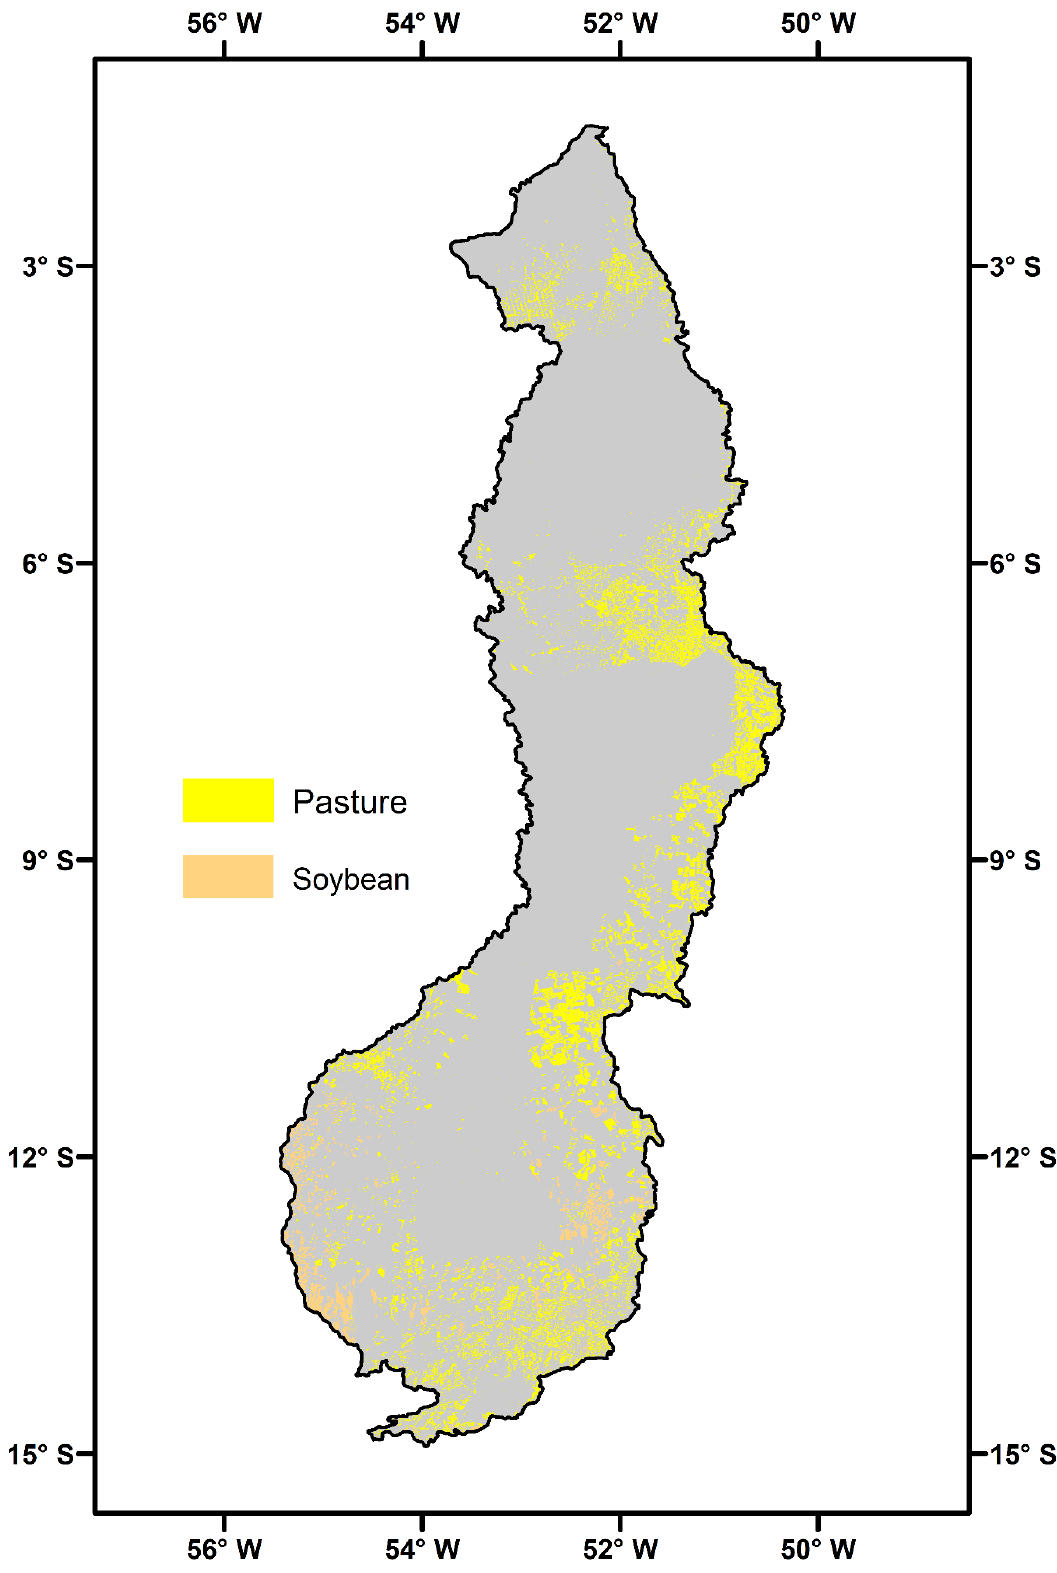
Figure 3. Pasture and soybean areas in the Xingu River Basin for the 2001–2013 period. The map was obtained by using the TerraClass [31] and MapBiomas [32] mappings and visual inspection based on TM / Landsat 5